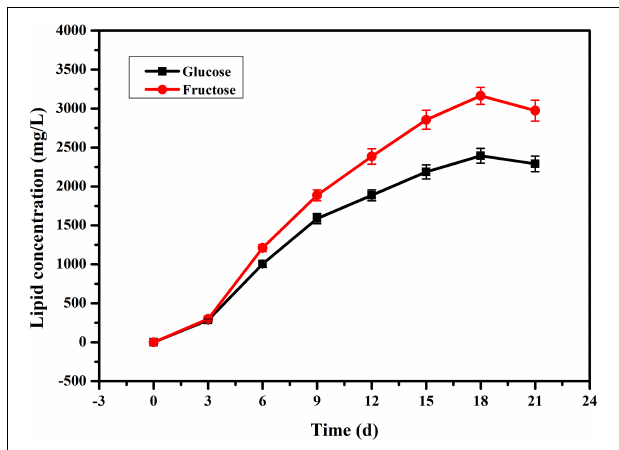
FIGURE 3 | Comparison of the lipid concentrations in the mycelia of G. lozoyensis grown on glucose and fructose, respectively. The data were presented as the averages of three parallel samples, and the error bars indicate the standard deviation (SD) from the means of